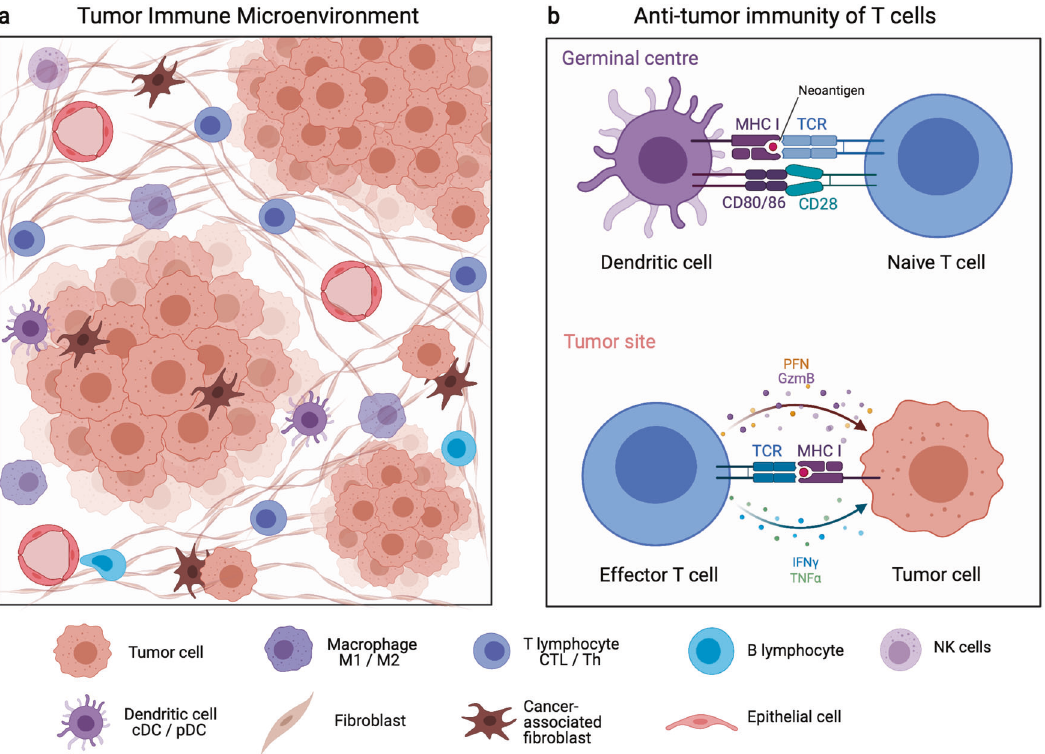
Fig. 1 Components and interactions of the tumor immune microenvironment. a Cellular compositions of the tumor immune microenvironment. b Brief illustration of cell – cell interaction in anti-tumor immunity. cDC conventional dendritic cells, CTL cytotoxic T lymphocyte, Gzm granzyme, IFN interferon, MHC major histocompatibility complex, NK cells natural killer cells, pDC plasmacytoid dendritic cells, PFN perforin, TCR T cell receptor, Th T helper cell, TNF tumor necrosis